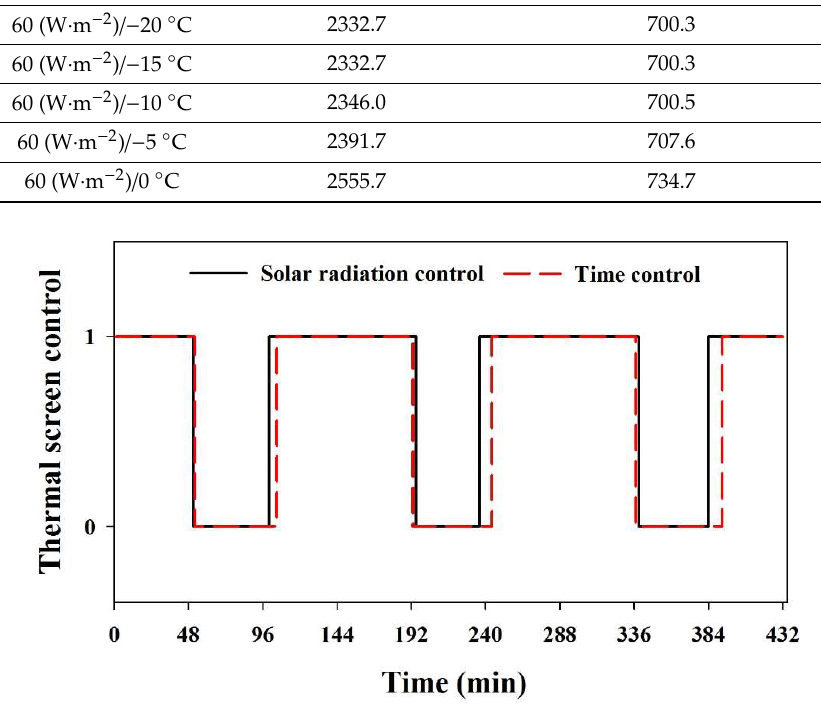
Figure 15. Thermal screen control with different control strategies.